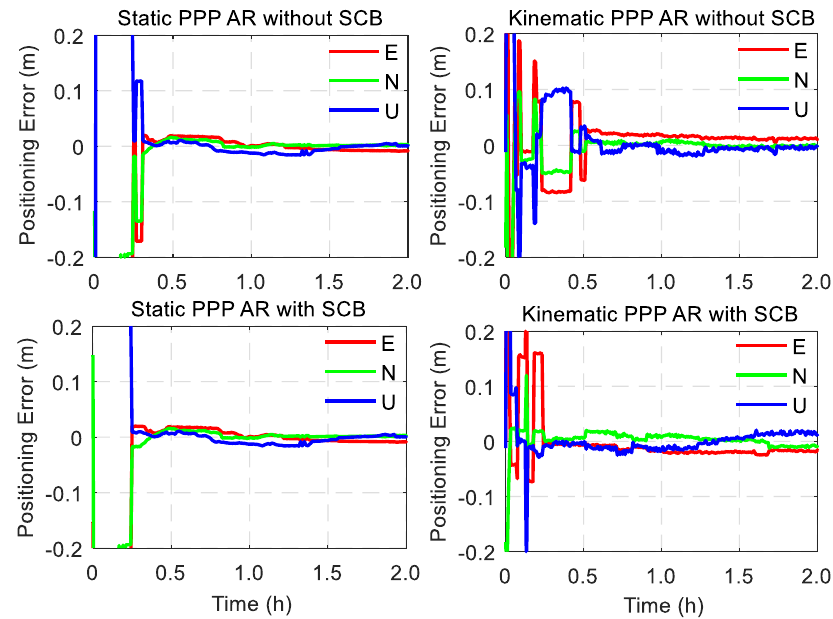
Figure 3. Two-h time series of position errors for triple-frequency UDUC-PPP AR with or without observable-specific SCB corrections at BRUX stations.